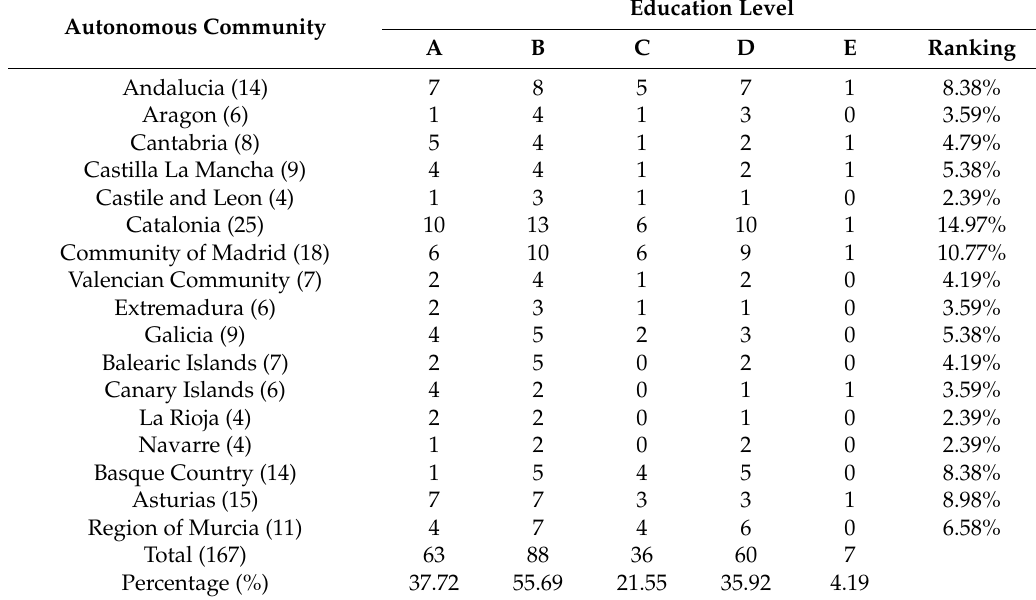
Table 3. Entrepreneurship education programs by autonomous